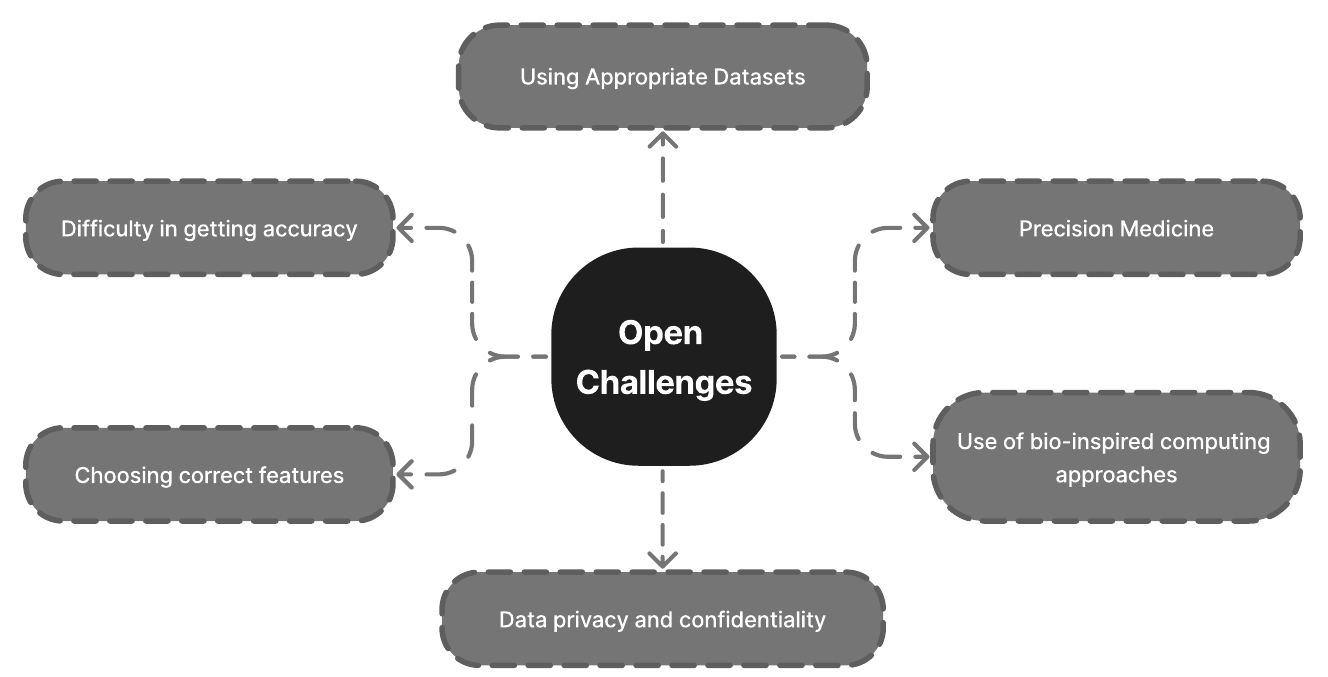
Figure 11. Open Challenges for Oral Cancer Diagnosis .